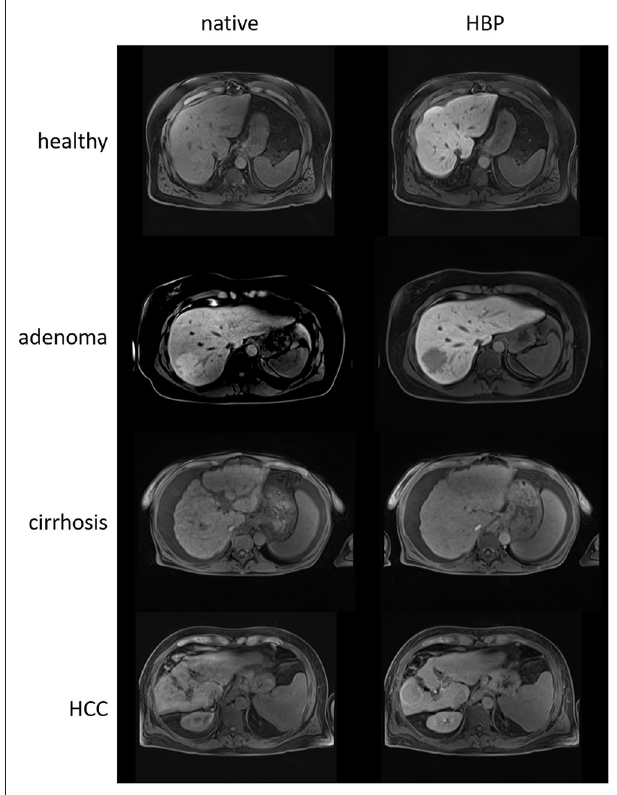
FIGURE 1 | Native and hepatobiliary-phase (HBP) T1 images of a healthy liver (56 years, male), a liver with an adenoma in liver segment VII (48 years, female), a cirrhotic liver (60 years, female), and a cirrhotic liver with a hepatocellular carcinoma (HCC) in liver segment VI (59 years, male) using gadoxetic acid as the contrast agent. The healthy liver clearly appears more hyperintense than the cirrhotic liver in the HBP image relative to the native image due to the ability of more functional hepatocytes to take up the contrast agent. Both adenoma and HCC appear hypointense in the HBP images.